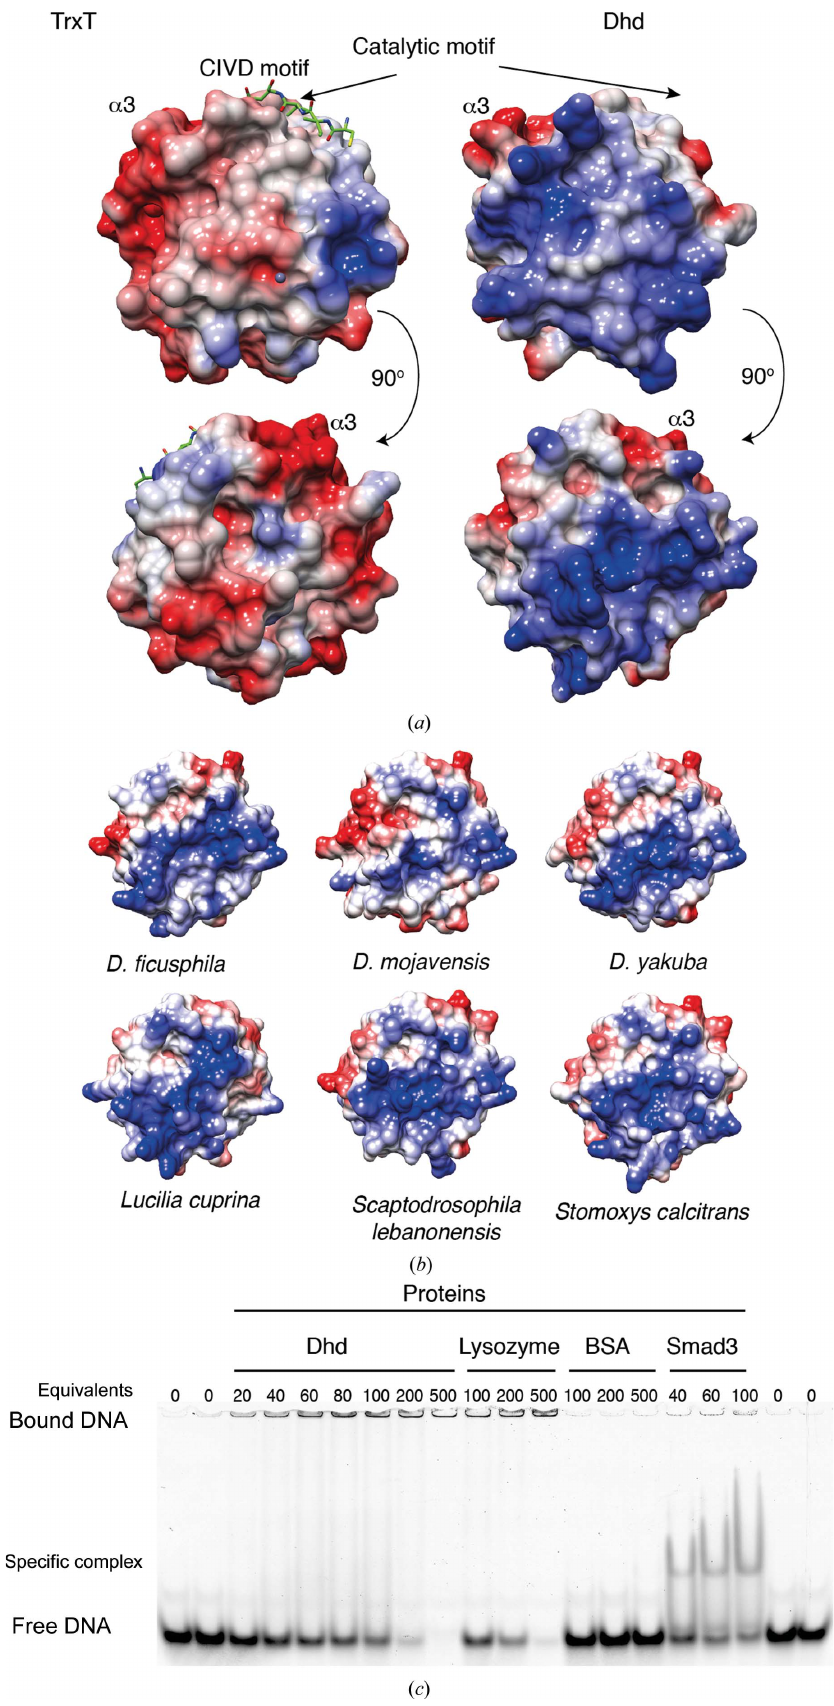
Figure 5 Charge distribution and DNA binding. ( a ) Surface-charge distribution for the TrxT (left) and Dhd (right) proteins. Both sides of the surface are displayed. The catalytic site, the (cid:3) 3 helix and the C-terminal CIVD motif of TrxT are indicated. ( b ) Surface-charge distribution of Dhd proteins generated using the Dm Dhd structure as a template. The molecules are oriented as in the top view in ( a ). The other side is represented in Supplementary Fig. S4( c ). ( c ) The DNA-binding capacity of Dm Dhd compared with those of lysozyme, BSA and the MH1 domain of Smad3. Protein concentrations are indicated at the top of the gel. The DNA is at 7.5 n M . Dm Dhd and Smad3 interact with DNA at a 40 equivalents protein excess, although the interaction of Dhd is nonspecific whereas Smad3 binds to a single site in this